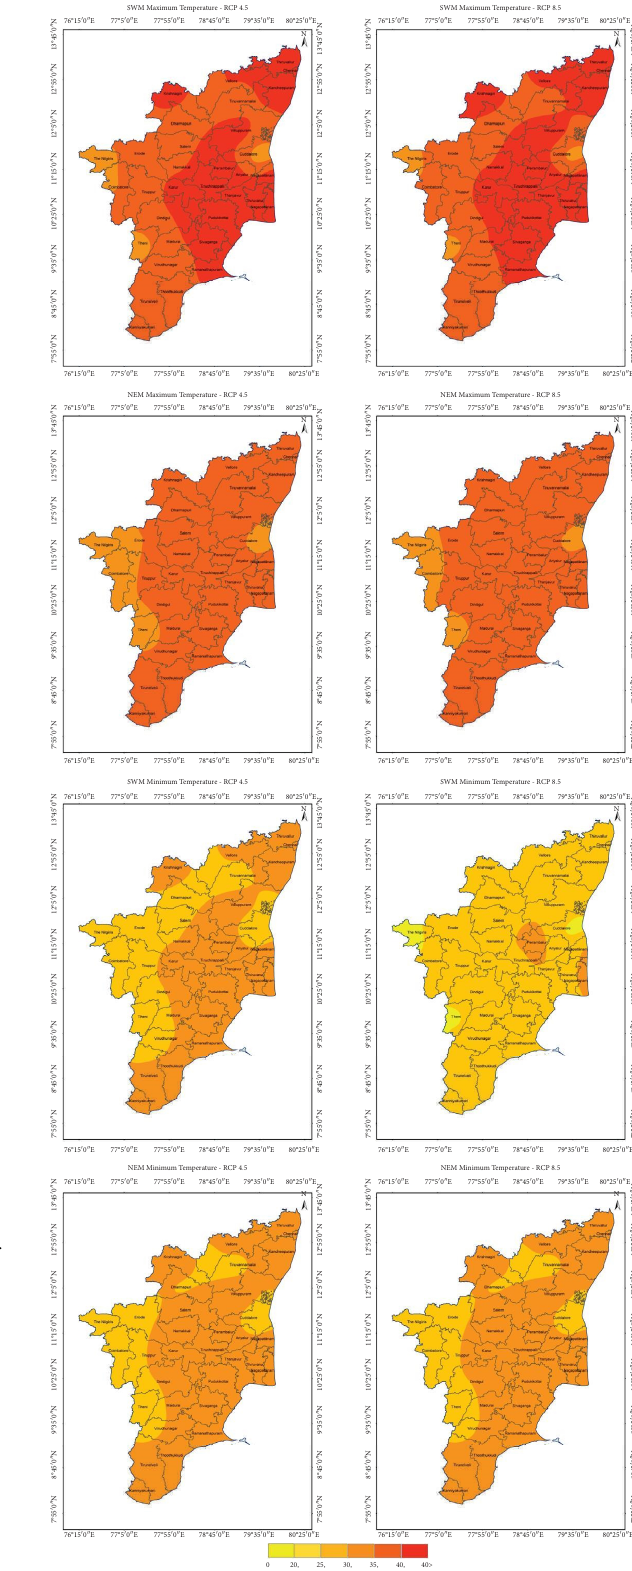
Figure 3: Multi-climate model ensemble projection of maximum and minimum temperatures ( ° C) for RCP 4.5 and RCP 8.5 sce- narios for the